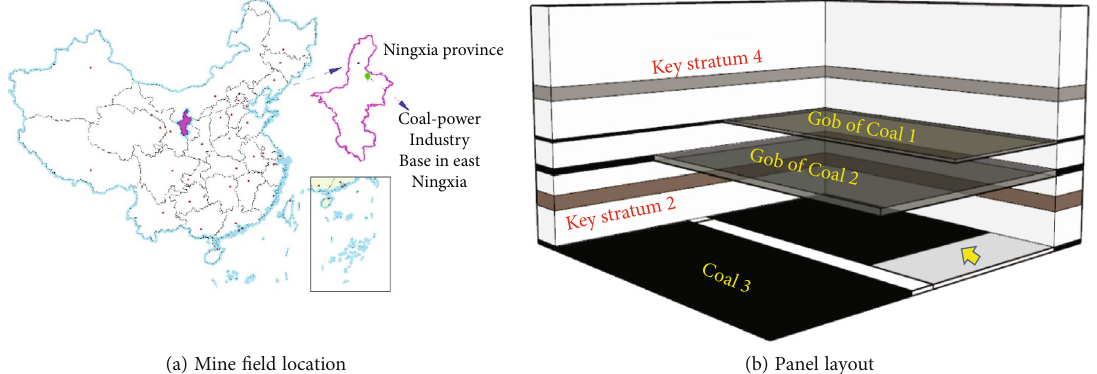
Figure 2: Mining area location and